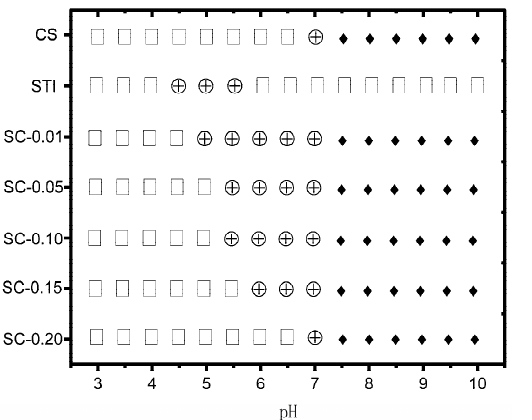
Figure 1. Phase behavior of STI, CS, and mixed systems (SC–0.01, SC–0.05, SC–0.10, SC–0.15, SC–0.20) Figure (cid:561) 1. (cid:561) Phase (cid:561) behavior (cid:561) of (cid:561) STI, (cid:561) CS, (cid:561) and (cid:561) mixed (cid:561) systems (cid:561) (SC–0.01, (cid:561) SC–0.05, (cid:561) SC–0.10, (cid:561) SC–0.15, (cid:561) SC– with pH 0.20) (cid:561) with (cid:561) pH (cid:561) variation. (cid:561)